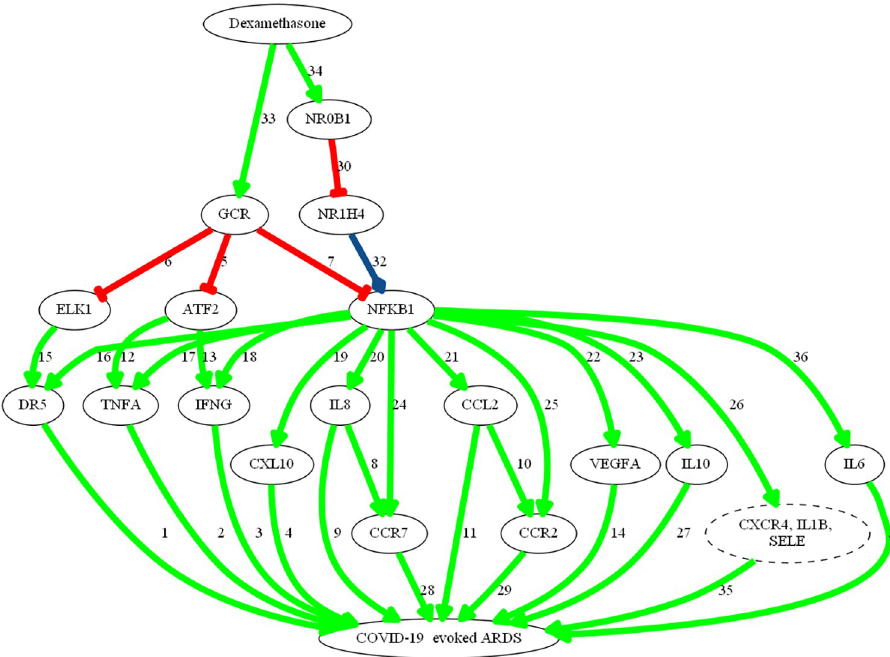
Fig 3. Mechanism of action of dexamethasone. Figure created to represent TPMS MoA predictions using Graphviz software. All links have been manually reviewed: the number of the links correspond to the reference code (link number) in S5 Table. Green arrows show activation; red line shows inhibition; blue lines show complex or dual relationships; broken-lined circles indicate a node that contains more than one protein, all acting in the MoA in the same